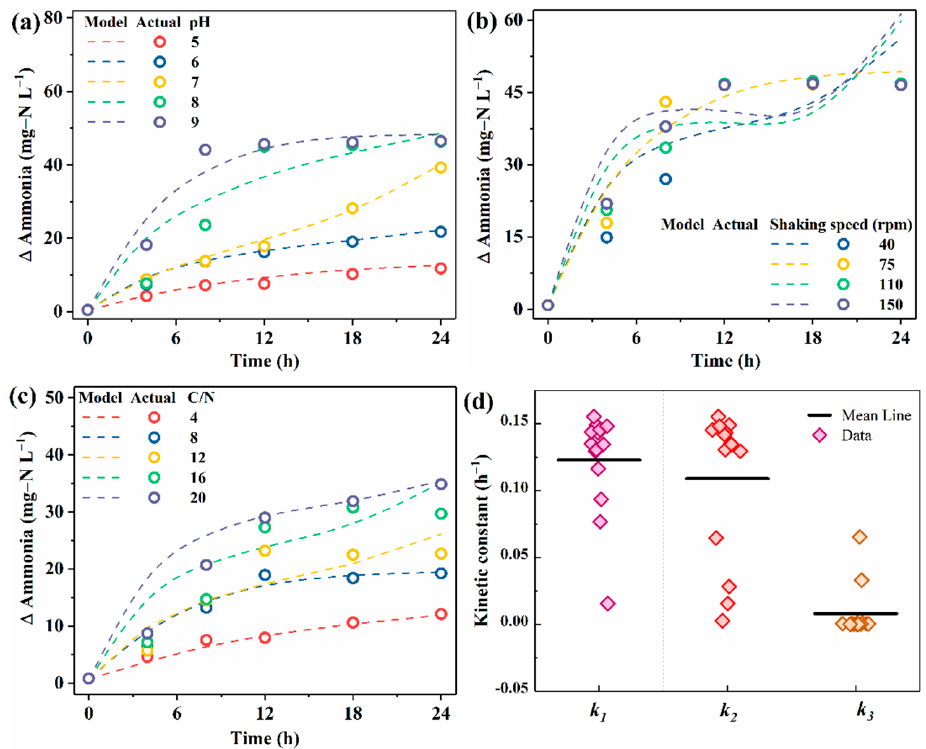
Figure 6. Kinetics of substrate utilization as a function of ( a ) pH, ( b ) speaking speed, and ( c ) C/N ratio; ( d ) kinetic constants of nitrogen removal of P. aeruginosa strain LS82 under various conditions